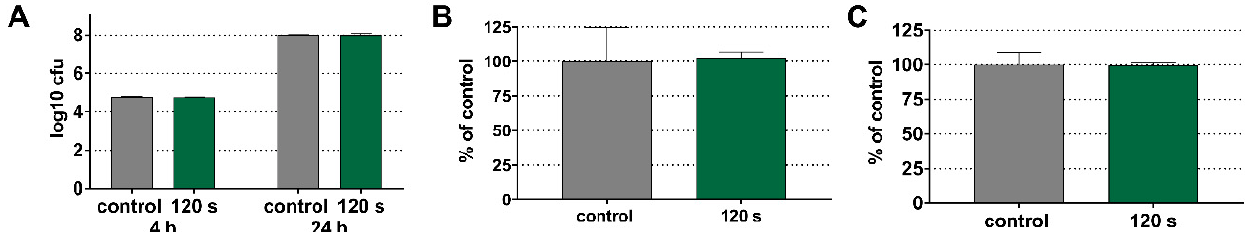
Figure 5. Colony forming units (CFU) counts ( A ) after 4 h and 24 h, mass ( B ), and metabolic activity ( C ) after 24 h of a multi-species biofilm formation on titanium specimens immediately after the application of 120 s of cold plasma.